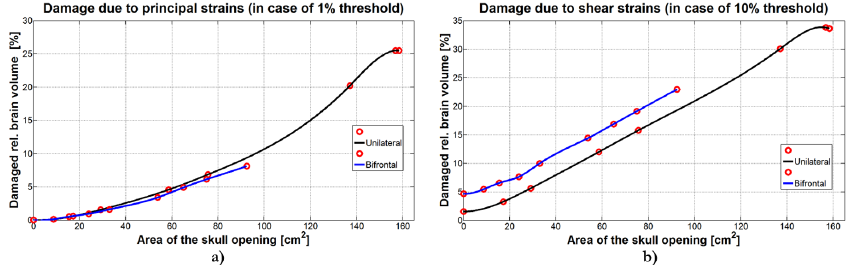
Figure 6. Tendencies of damaged brain volume in case of different skull opening